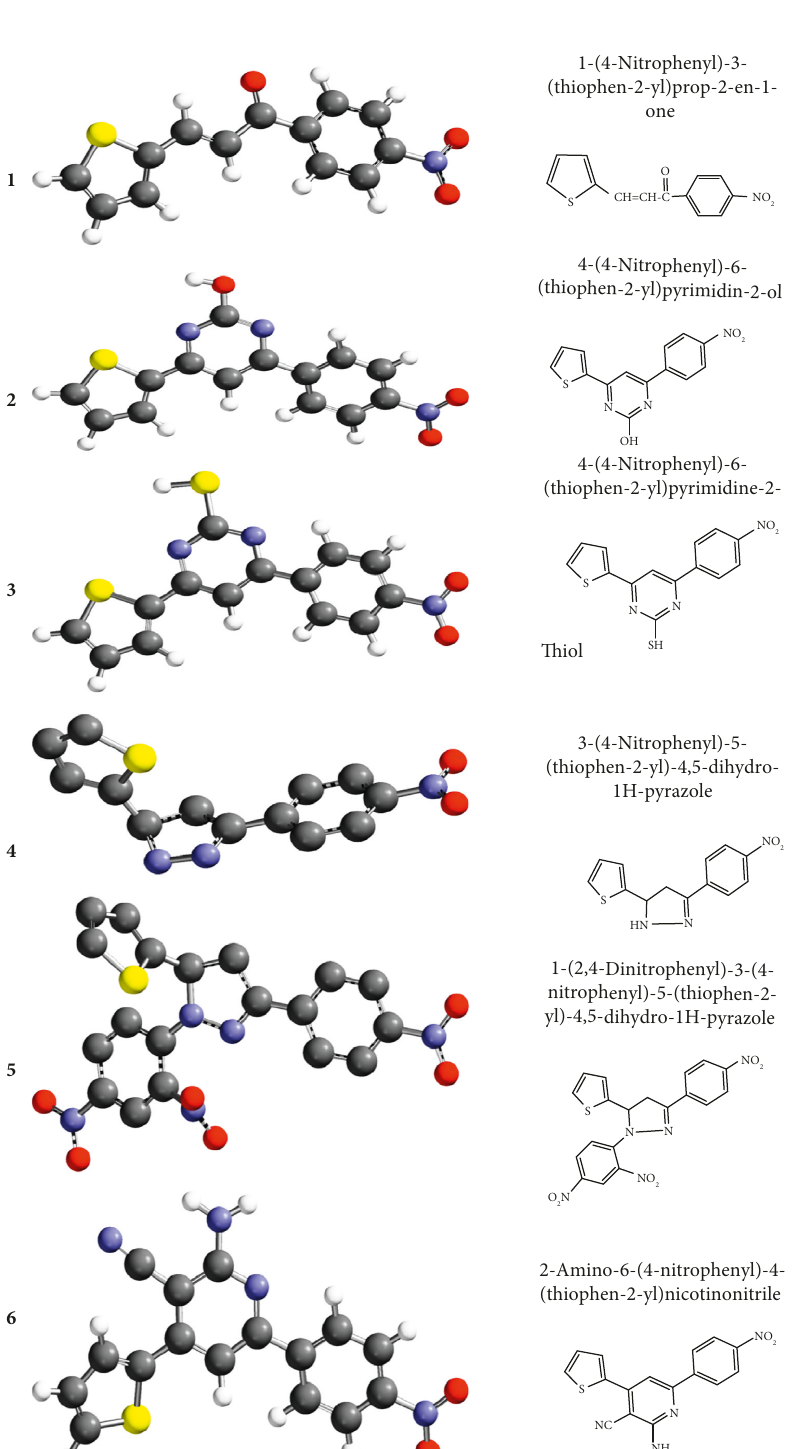
Figure 1: Optimized geometries (best view) of chalcone ( 1 ) and newly synthesized molecules (left side) as well as nomenclature (right side). Hydrogen atoms are removed from some molecules for